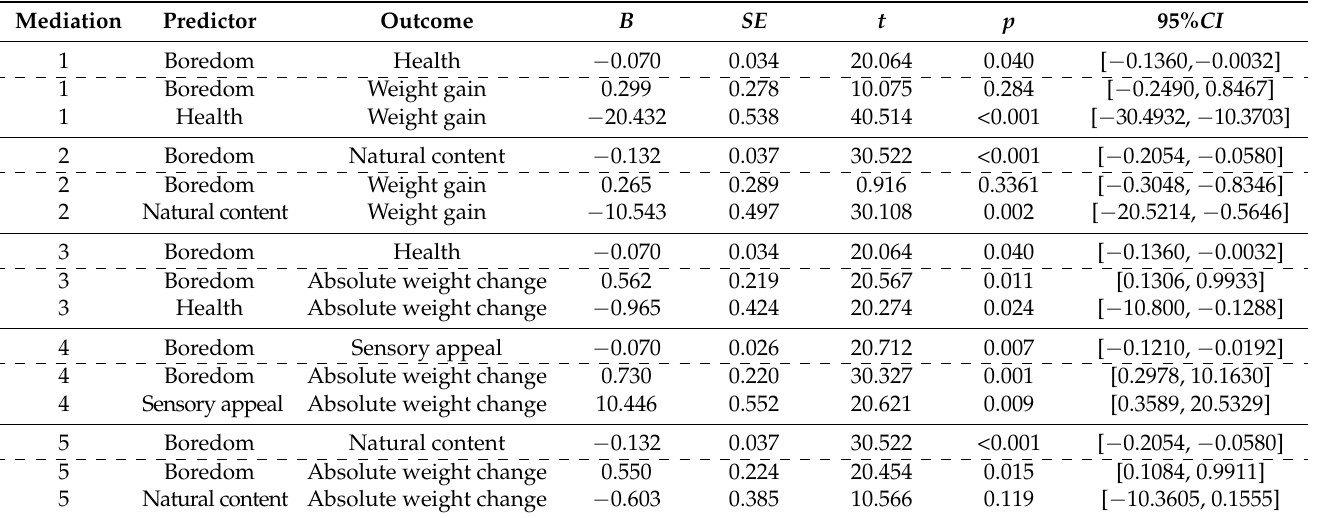
Table 2. Mediation